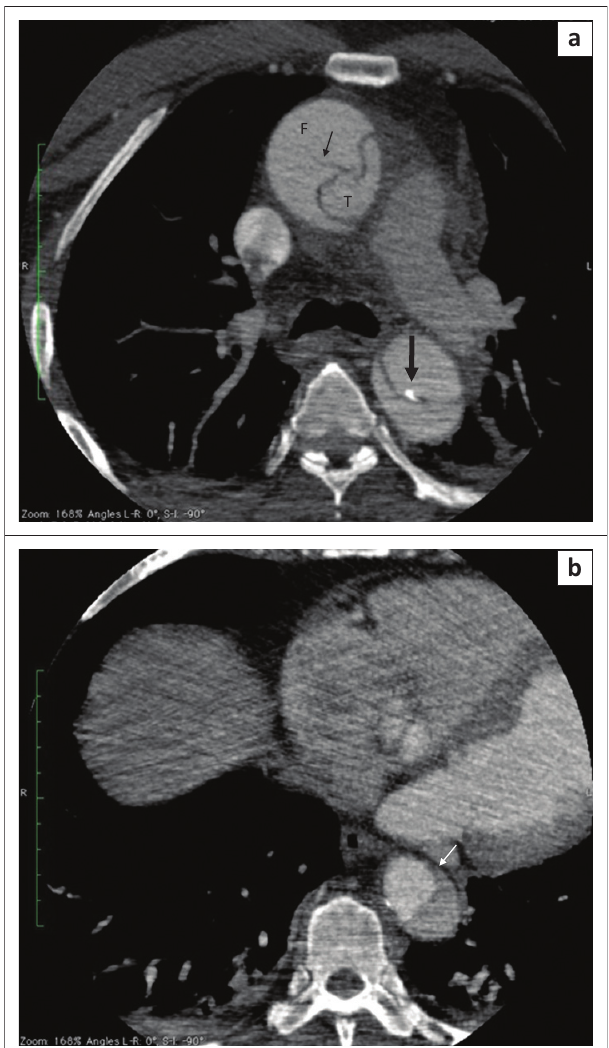
FIGURE 3: (a) Contrast-enhanced axial computed tomography (CT) scan showing intimal calcifications around the true lumen (thick arrow) and linear scattered hypodense areas within the false lumen termed the Cobweb sign (thin arrow), representing the remnants of media. The calibre of the true lumen (T) appears smaller than the false (F). (b) Axial contrast-enhanced CT scan showing a beak sign (arrow) which is a wedge of haematoma at the distal end of false lumen forming an acute angle with the vessel wall.